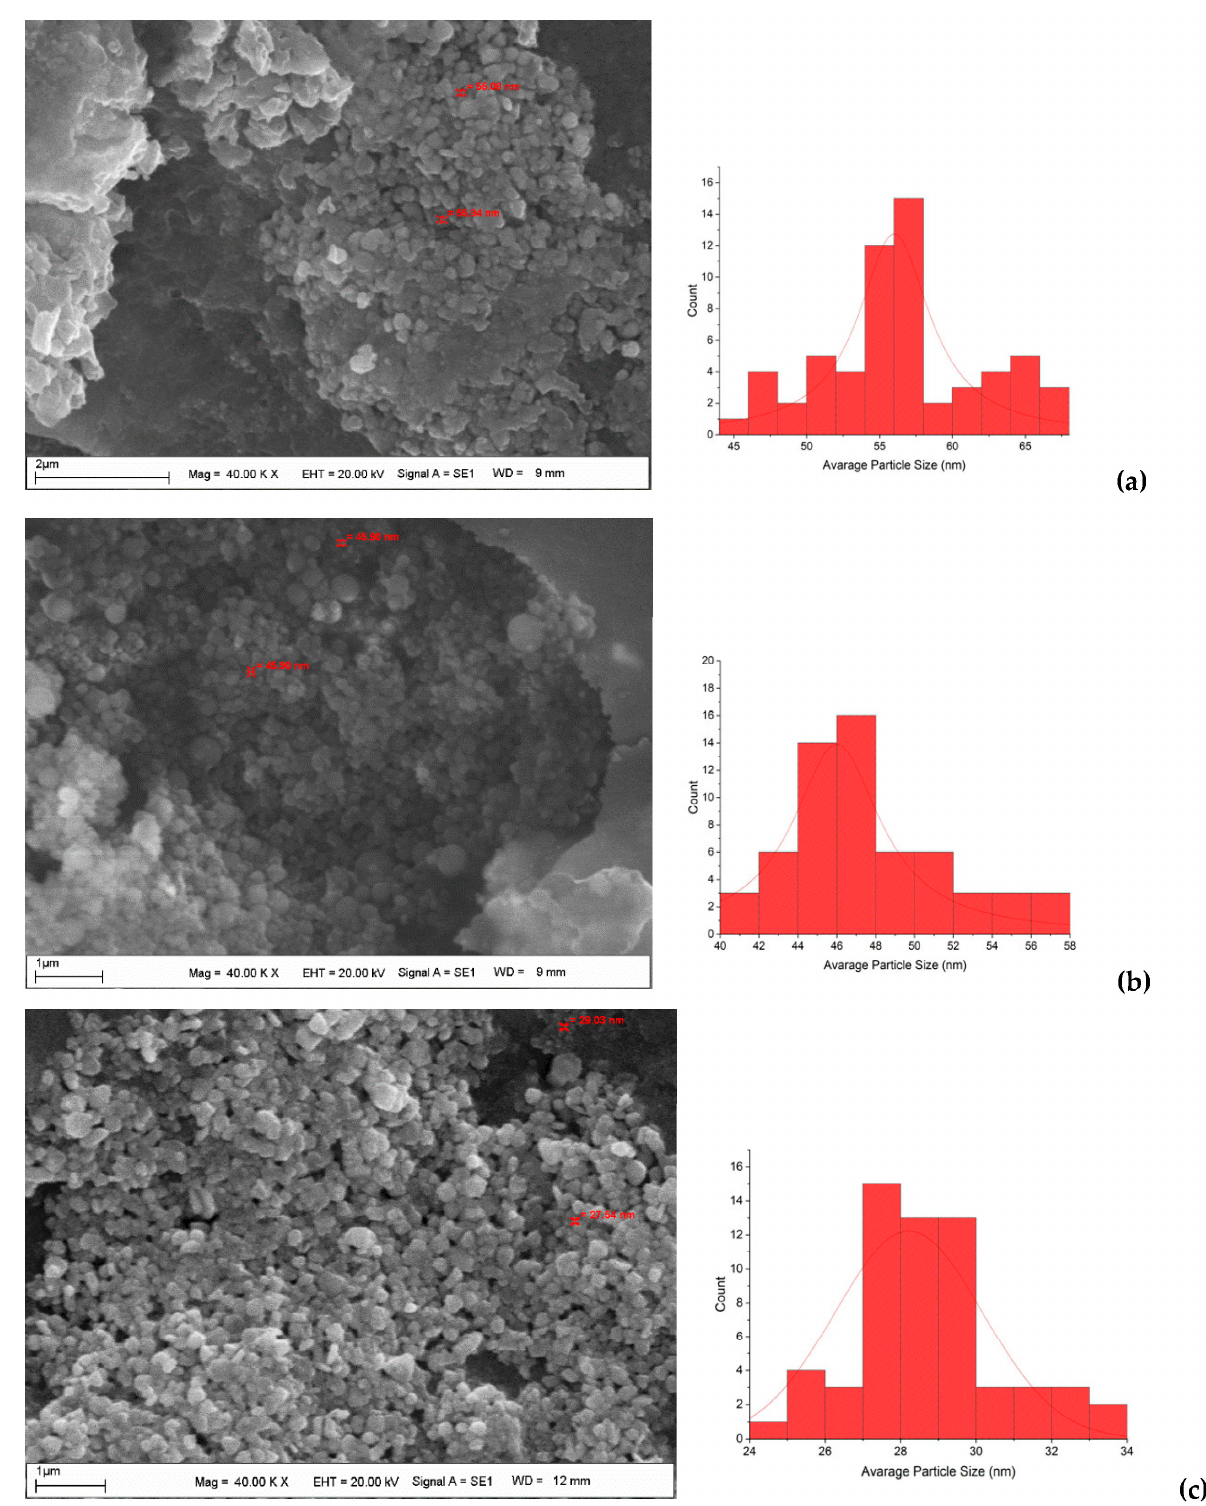
Figure 2. SEM images and histograms of CH-AgNPs at 30 ( a ), 60 ( b ) and 90 °C ( c ).